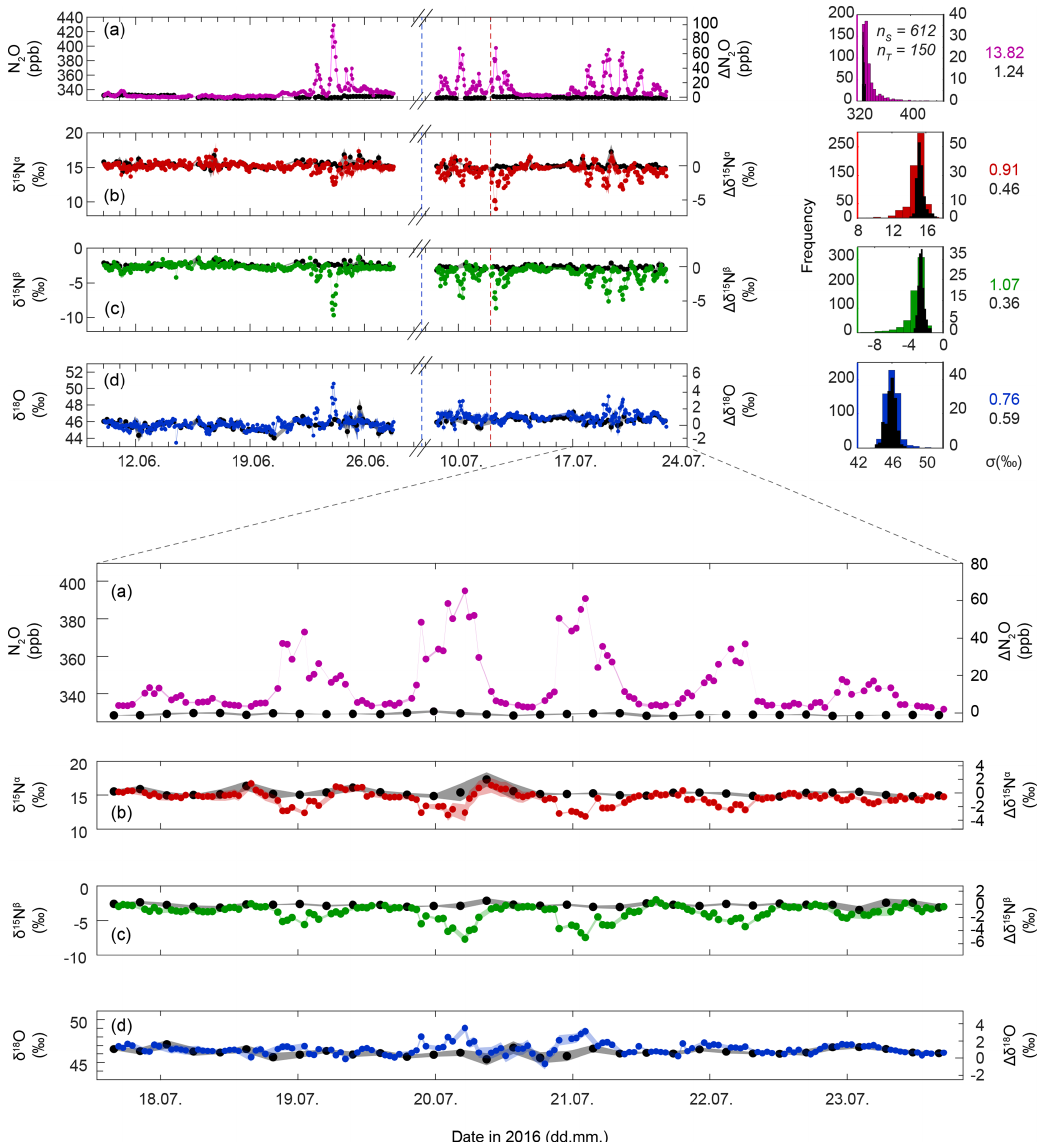
Figure 4. Time series of N 2 O concentrations (a) , δ 15 N α (b) , δ 15 N β (c) , and δ 18 O (d) , respectively. The left axes give concentrations and isotope delta values on the respective scales, while the right axes depict the difference to background values ( δX = X measured − X background , where X refers to N 2 O, δ 15 N α , δ 15 N β or δ 18 O). At the top right, histogram plots of the four quantities are given. Coloured symbols indicate ambient air samples (S) from 2ma.g.l., and black symbols refer to the corresponding measurements of the target gas (T; Table 2). Shaded areas indicate 1 standard deviation ( σ ) as calculated for three consecutive measurements of T. Standard deviations for the complete measurement period are given on the right, in coloured font for S and in black for T. The vertical blue dashed line indicates a cutting event on 4 July 2016, while the red dashed line indicates manure application on 12 July